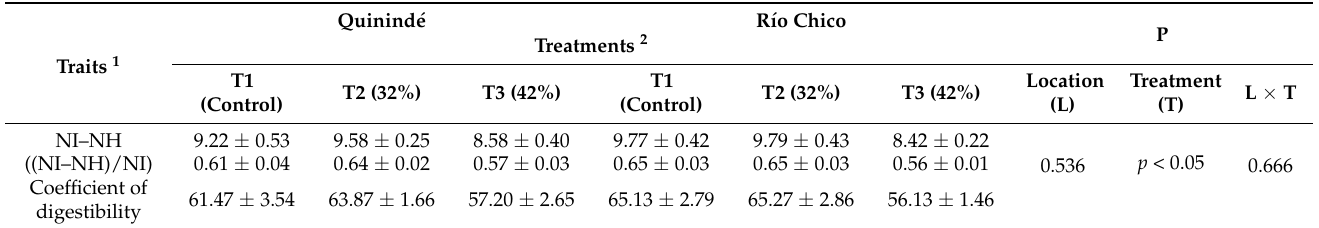
Table 7. Analysis of apparent ileum digestion (mean values are of (%) protein content) in backyard pigs from Ecuador fed with alternative cooked cassava and taro